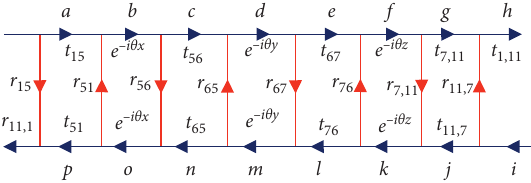
Figure 3: Reduced SFG representation for the optical